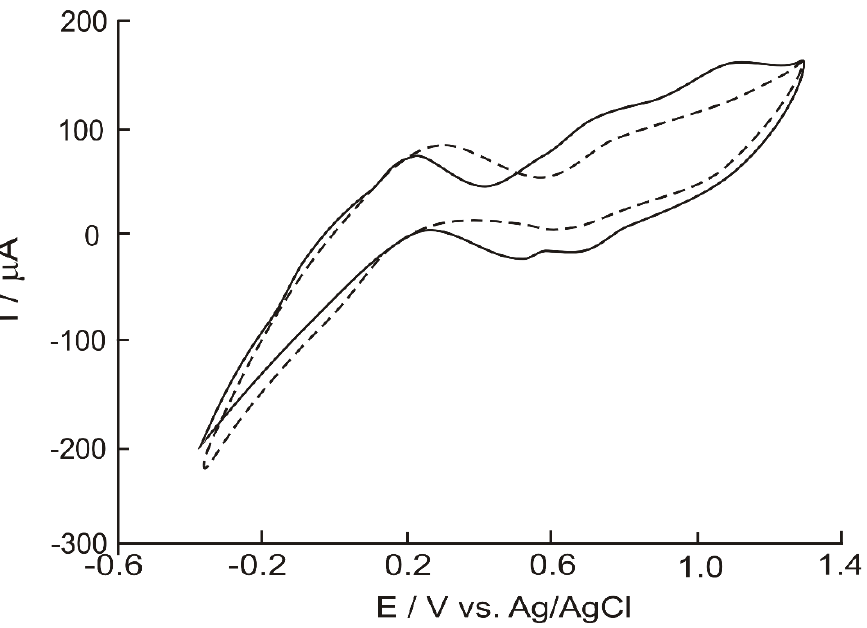
Figure 7. Cyclic voltammogram of SPCE/PB/HRP biosensor immersed in 20 μ M caffeic acid and 20 μ M caffeic acid solution in 10 − 2 M PBS pH 7–10 − 2 M hydrogen peroxide solution (solid line); cyclic voltammogram of SPCE/PB/HRP biosensor immersed in 10 − 2 M PBS pH 7–10 − 2 M hydrogen peroxide solution (dashed line).